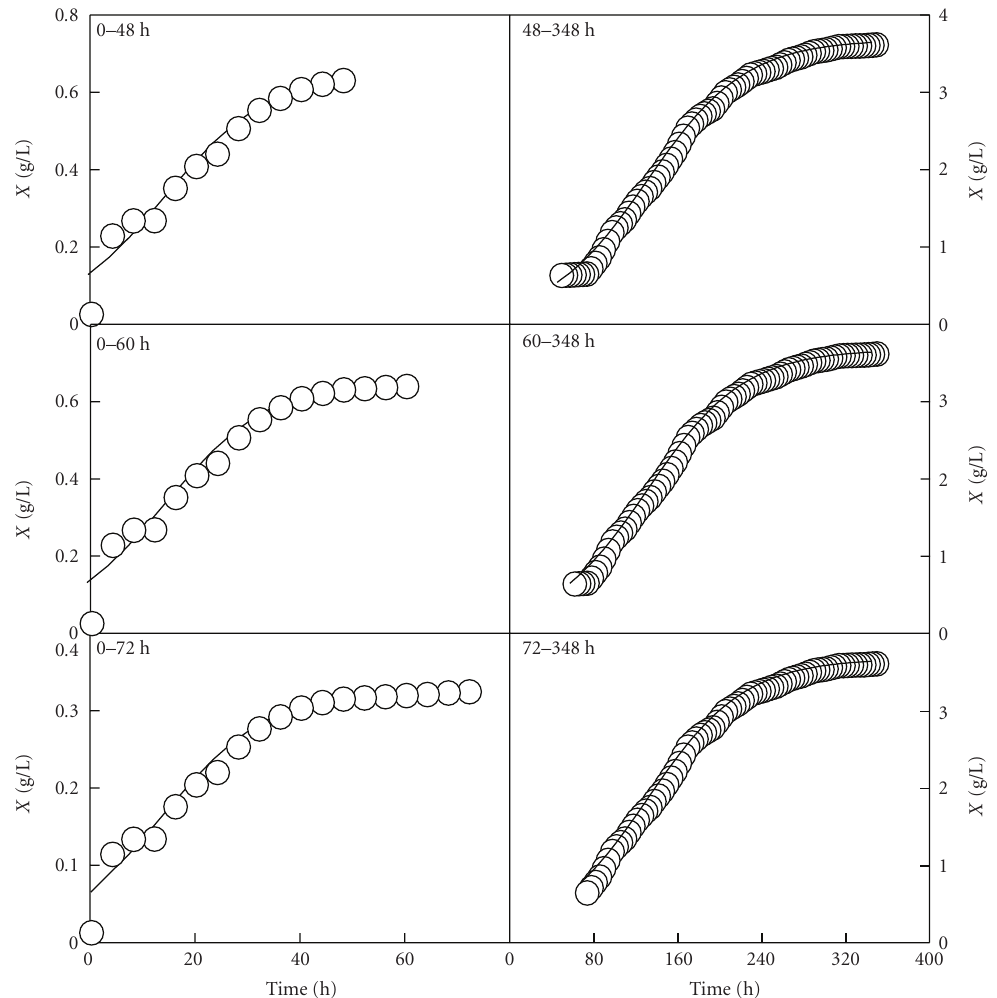
Figure 6: Growth curves of Ent. faecium CECT 410 corresponding to the first (left part) and second (right part) growth phases observed in the realkalized fed-batch fermentation II. The growth data (symbols) represented in the left and right parts are the biomass data showed in Figure 4. The solid lines drawn through the experimental biomass data (left and right part) were obtained according to the Logistic models (A.1) and (A.2), respectively.